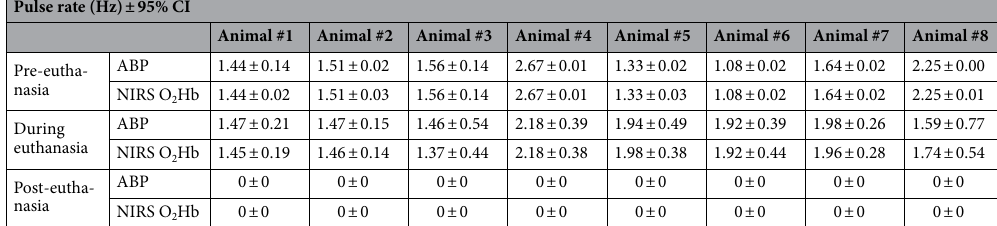
Pulse rate (Hz) ± 95%